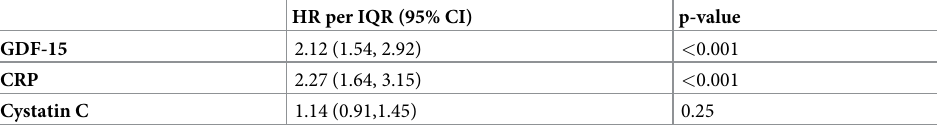
Table 5. Longitudinal biomarker measurements: Hazard ratios for incident HF estimated by joint models.